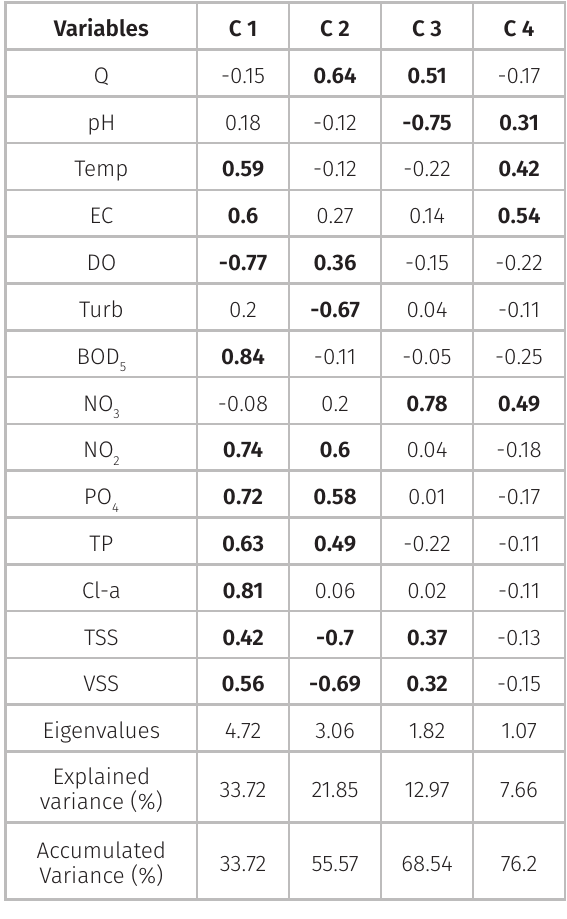
Table V. Factor loading of variables and principal components for the rainy